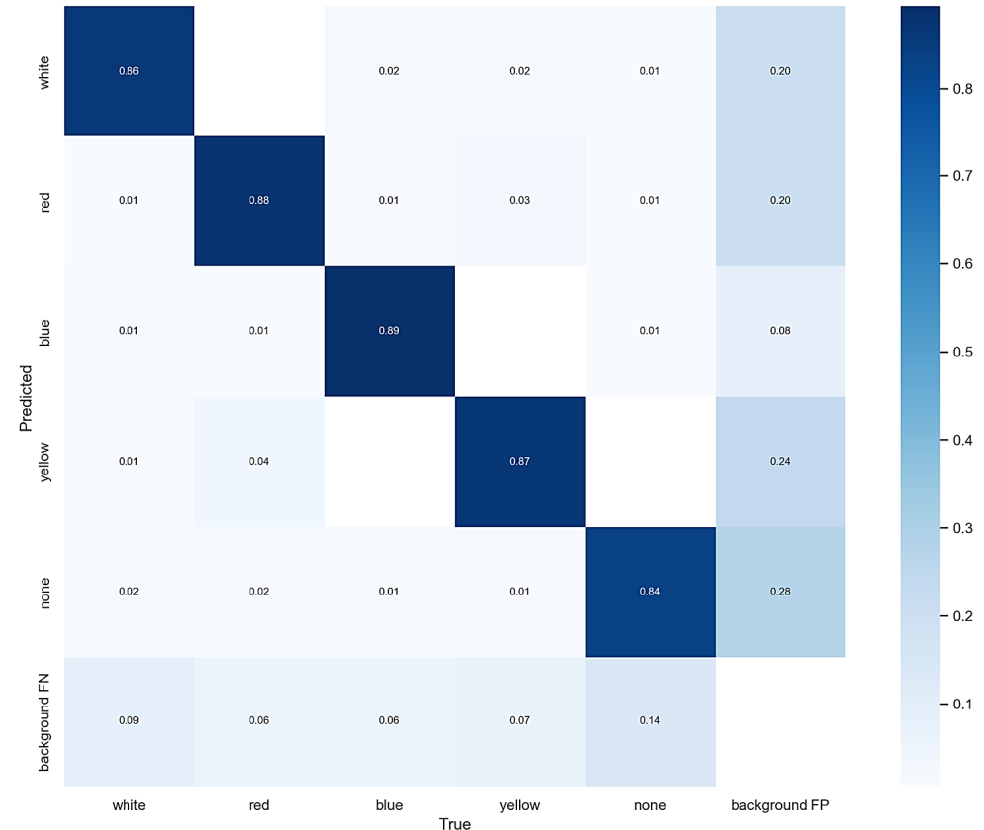
Figure 7. Confusion matrix of YOLO-v5 model.